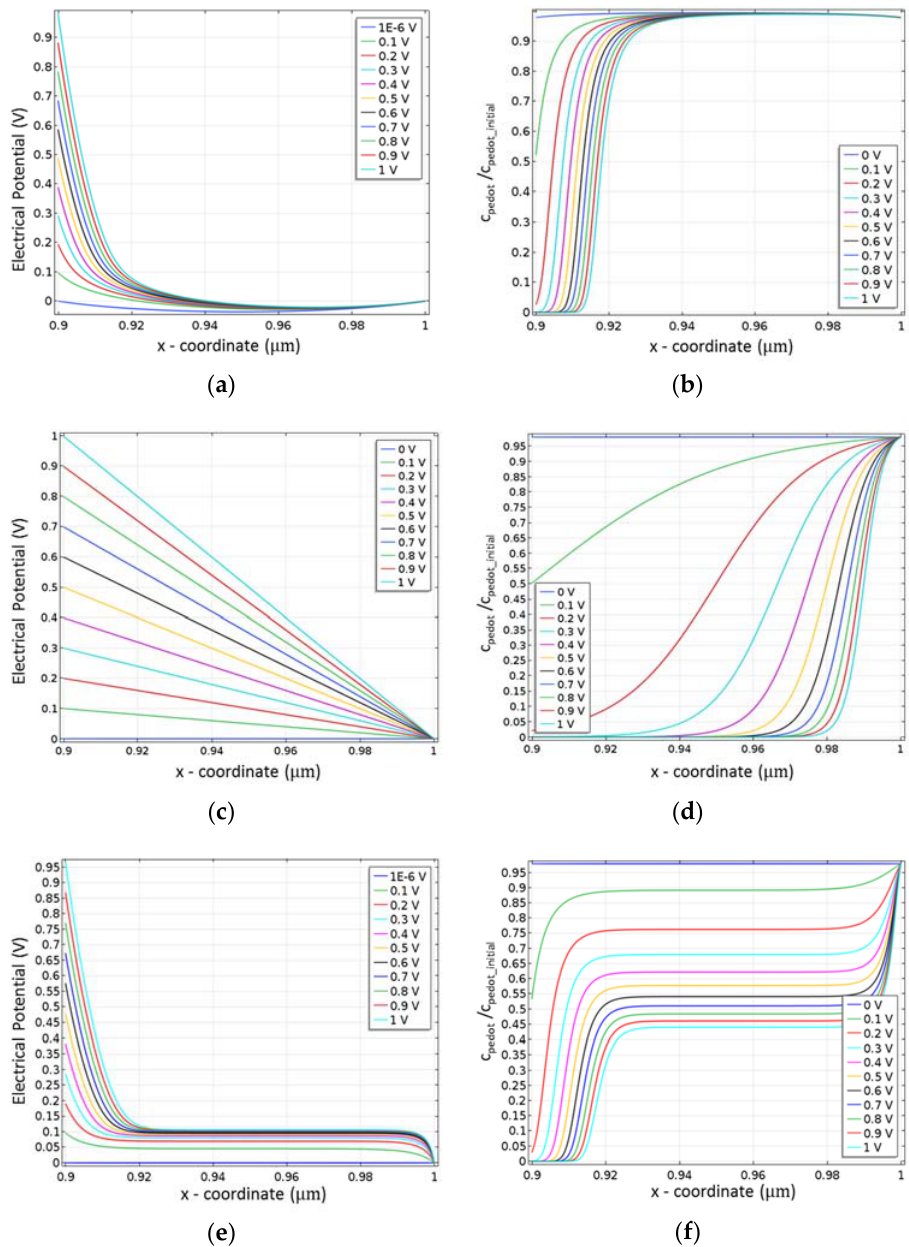
Figure 2. Calculated steady state data of the PEDOT:PSS layer at various applied gate-source voltages (from 0 V to 1 V, with 0.1 V step): ( a , c , e ) potential along the conductive polymer layer; ( b , d , f ) hole concentration profile. The potential and hole concentration was numerically evaluated in three cases: ( a , b ) no penetration of the cations; ( c , d ) local electrical neutrality; ( e , f ) global electrical neutrality.